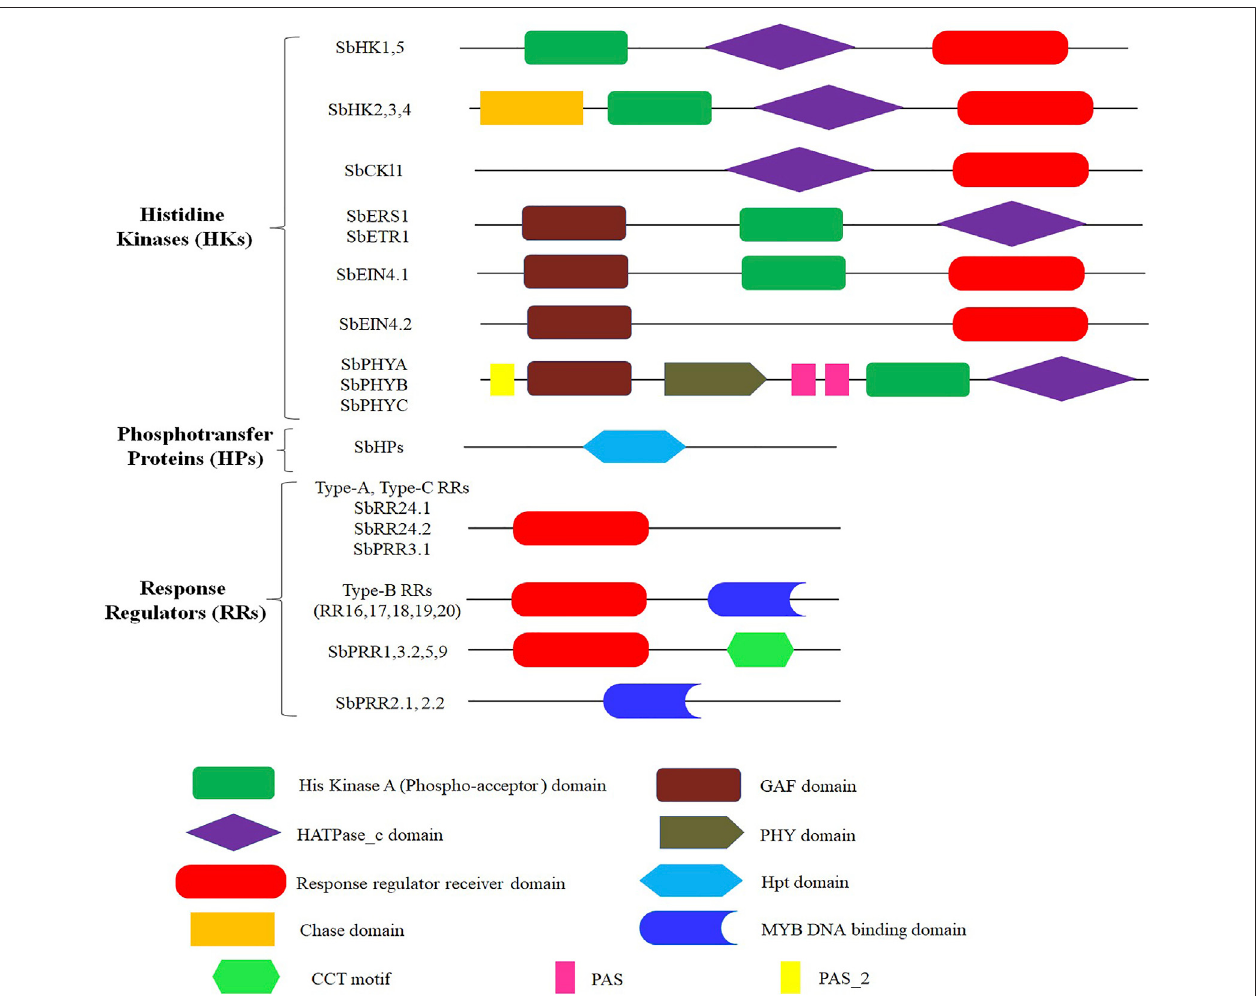
FIGURE 1 | Symbolic domain structure of S. bicolor two component signaling elements, different shapes and color represents different